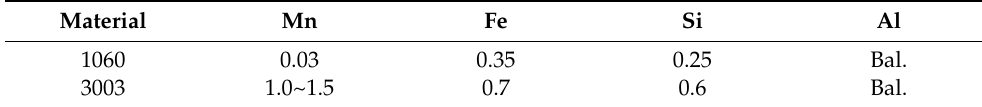
Table 1. Chemical composition of materials. (Mass fraction, %).